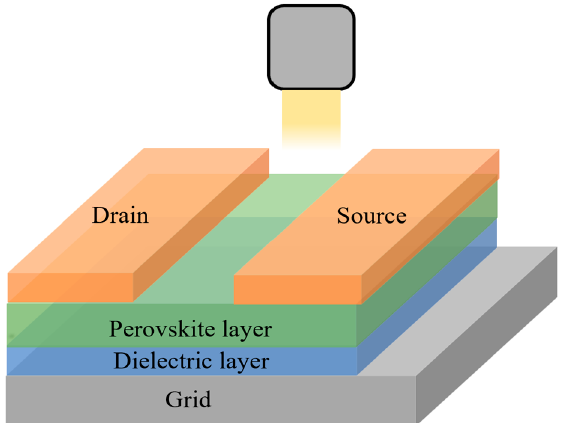
Figure 5. Structure diagram of the perovskite phototransistor.